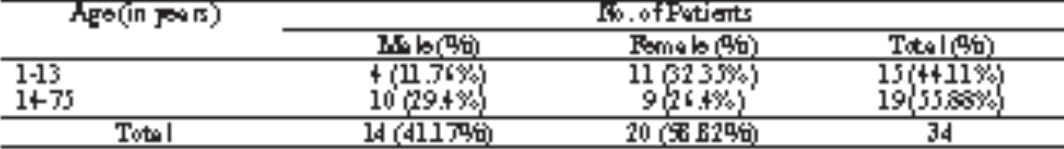
Table I: Demographic profile of the cases admitted with the diagnosis